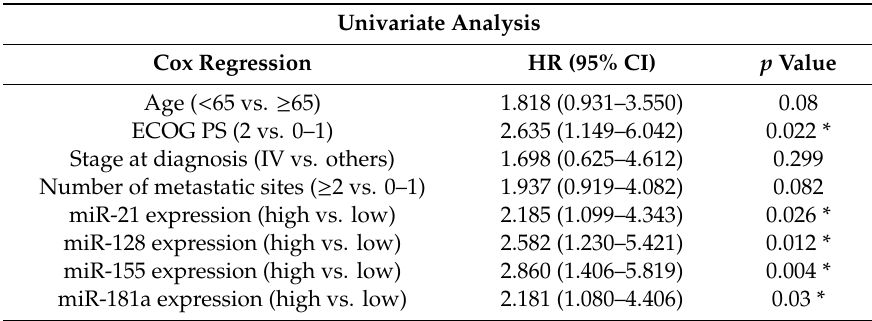
Figure 4. Kaplan Meier analysis for overall survival (OS) according to miRNAs expression in the plasma of squamous cell carcinoma (SqCC; n = 41) and non-squamous cell carcinoma (non-SqCC; n = 87) NSCLC patients. Patients were classified into high and low expression groups according to the median value of each miRNA. OS in patients with high or low expression of miR-21 ( A , B ), miR-128 ( C , D ), miR-155 ( E , F ), and miR-181a ( G , H ). Curves were compared using the log rank test. p values are shown. Table 4. Univariate and multivariate Cox regression analysis for overall survival in the squamous cell carcinoma (SqCC) subgroup of NSCLC patients.